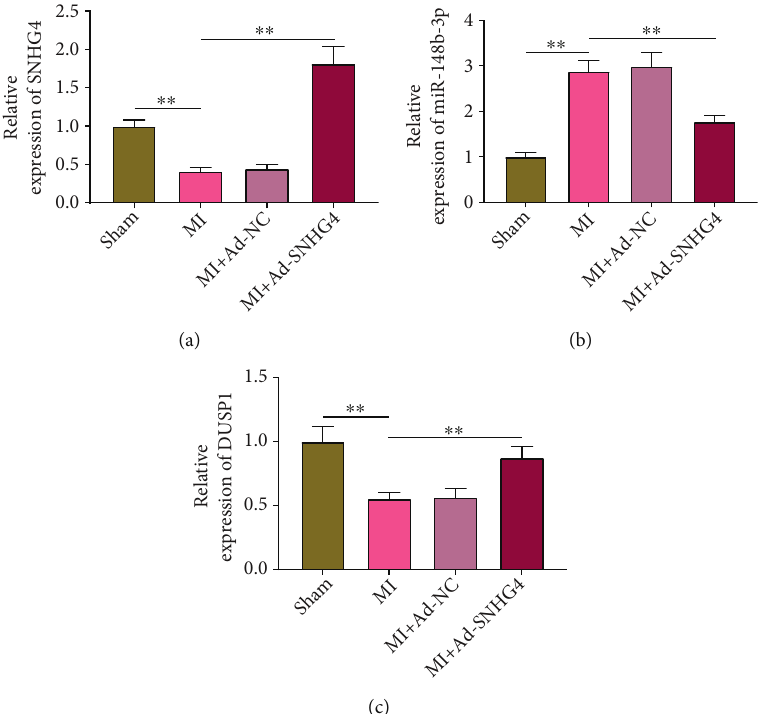
Figure 6: The expression of (a) SNHG4, (b) miR-148B-3p, and (c) DUSP1 in MI rats was detected by qRT-PCR. ∗∗ P < 0 : 01